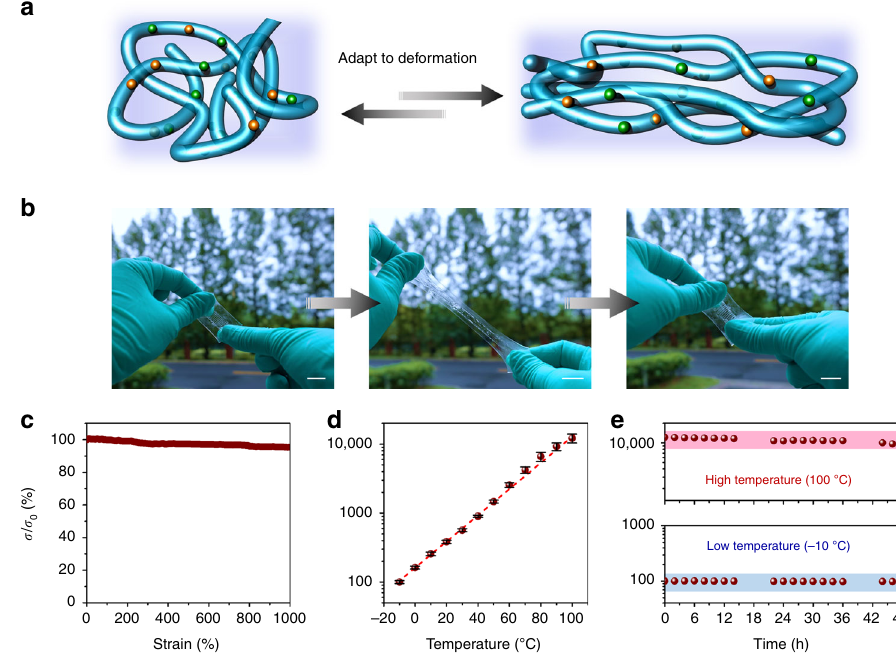
Fig. 4 Electrical properties in dynamic environments. a Schematic illustration of the conductive paths in this material adapting to deformation. Blue lines represent ion nanochannels and the purple parts represent the dynamic networks. b Photographs of the 3D-printing conductor during a stretch-release cycle (scale bar: 2 cm). c The stability of the ionic conductivity during the deformation process. d The relative changes in ionic conductivity in the temperature range of − 10 to 100 °C (error bars: standard deviations). e The stability of the ionic conductivity at extreme low or high temperatures for a long period. These measurements are humidity control (60